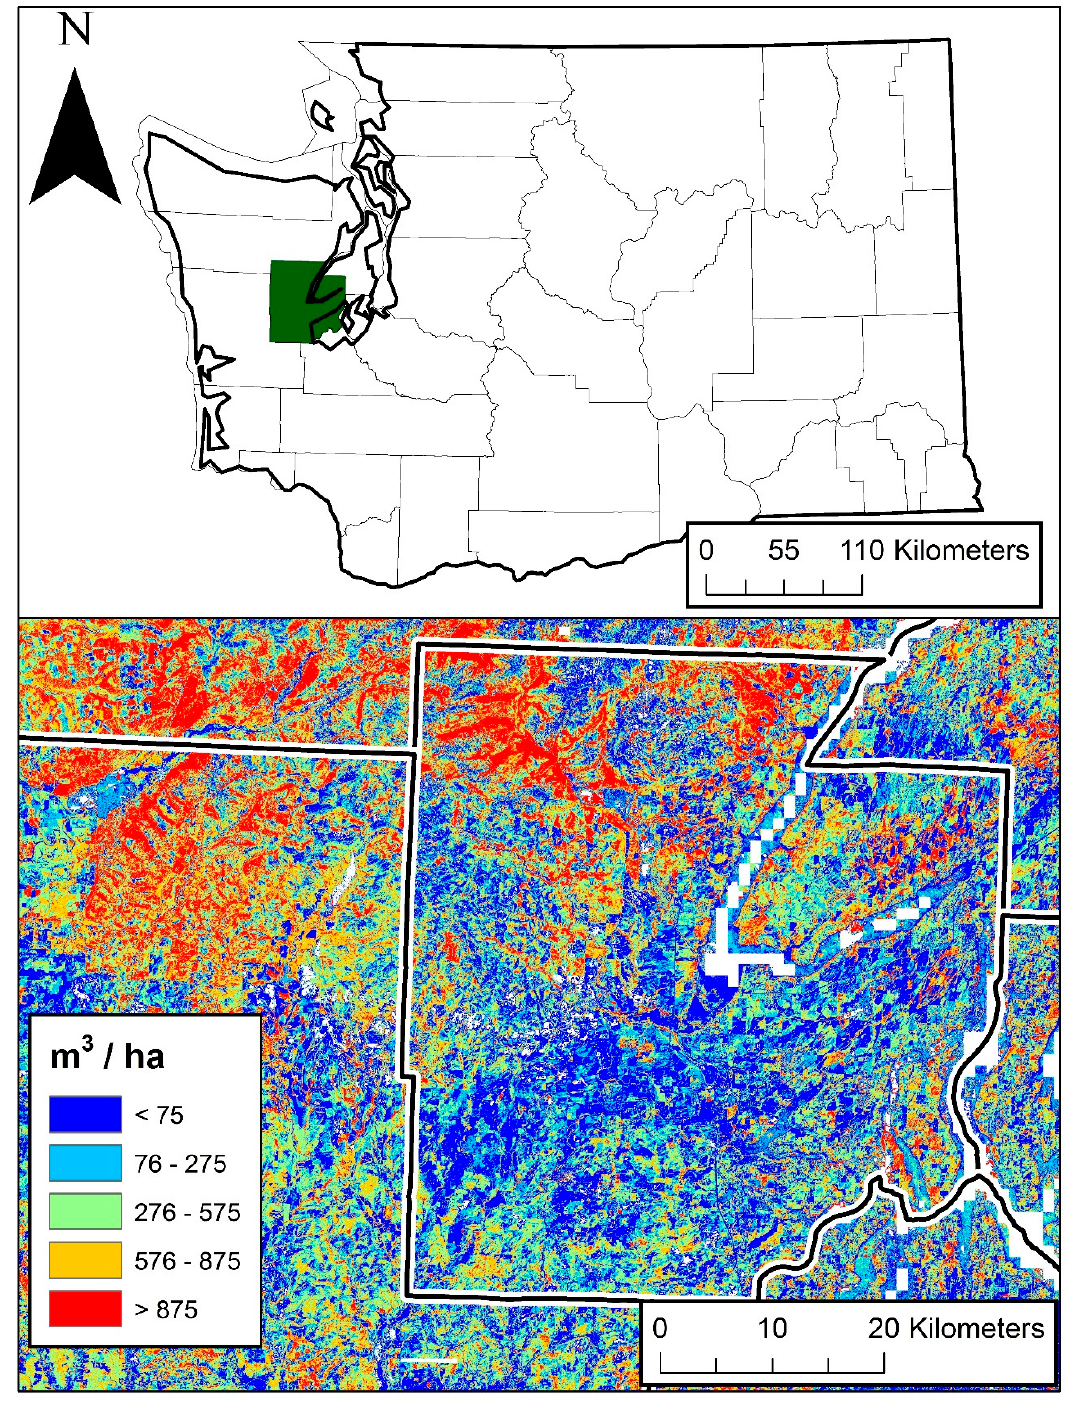
Figure 8. Gross cubic volume per hectare for Mason County (in green above) and surrounding areas in Washington State.